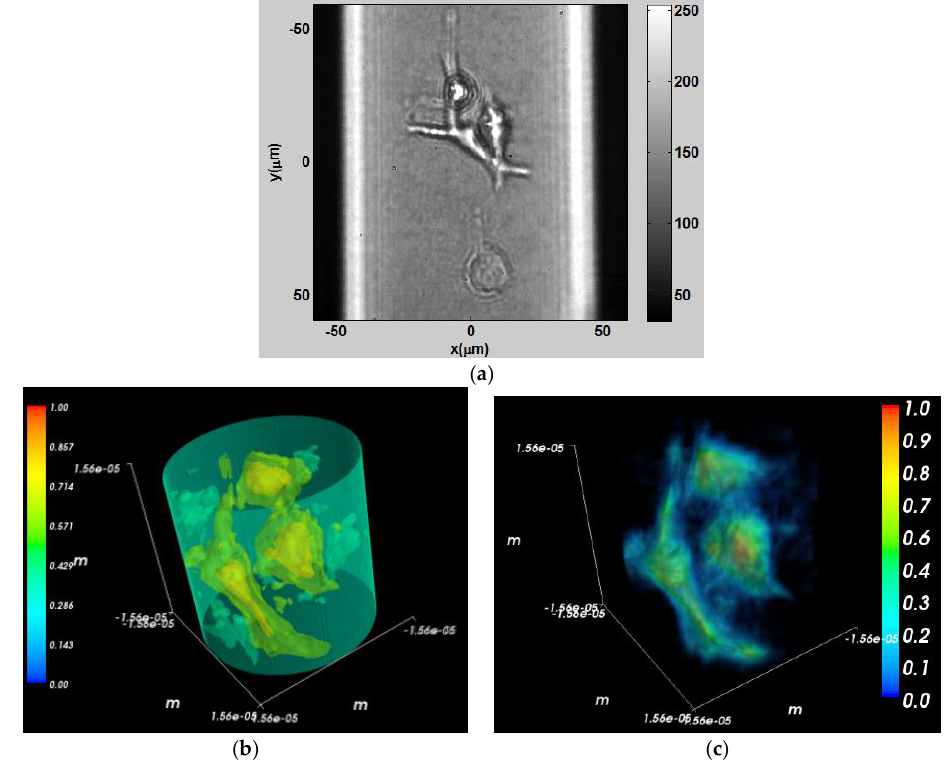
Figure 11. ( a ) Intensity distribution of a group of three cells placed in a micropipette; ( b ) 3D contour visualization of the refractive index; and ( c ) transparent 3D refractive index visualization with 3D rendering.